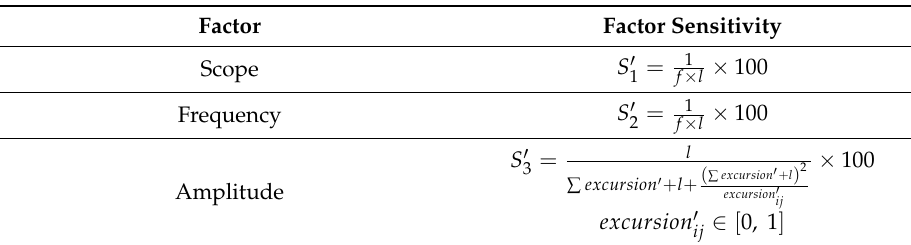
Table 3. Factor sensitivity of the Online Water Quality Index